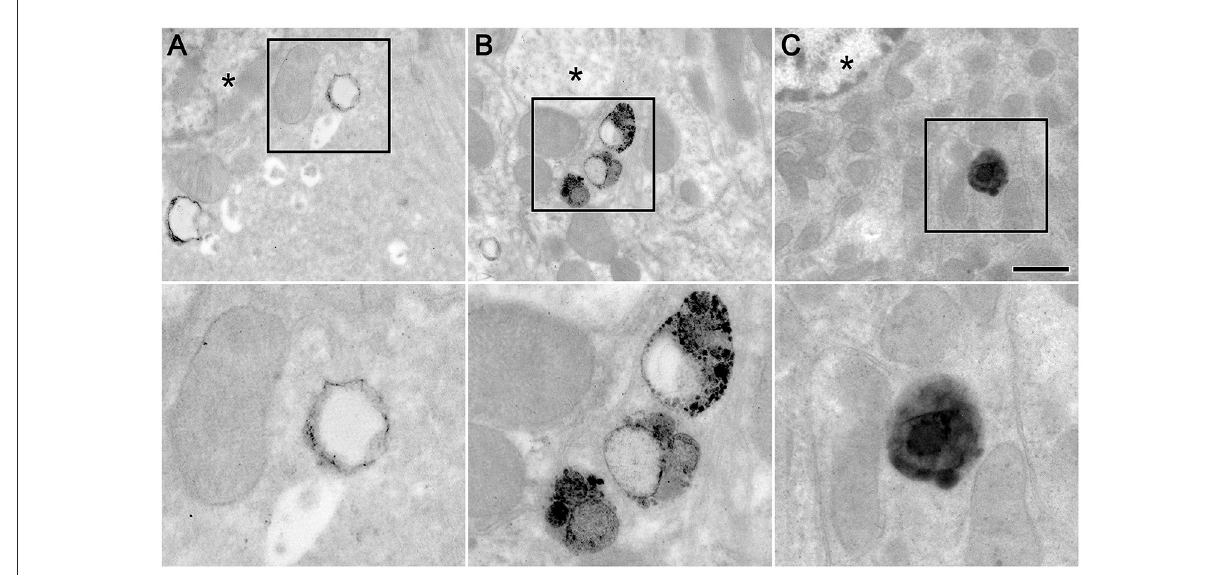
FIGURE4 Hepatocytes from mouse livers that were stained with ruthenium tetroxide, counterstained with osmium tetroxide, and imaged by transmission electron microscopy. Example images from (A) a control mouse that ingested aqueous vehicle, (B) a mouse that ingested 20nm PSNS, and (C) a mouse that ingested 200nm PSNS. Structures that resemble lysosomes, highlighted in the boxed areas, were observed in close proximity to the nucleus (*). The boxed areas were magnified by 2.5X and displayed in the lower panels. Scale = 1 µ m (top panels) and 400nm (bottom